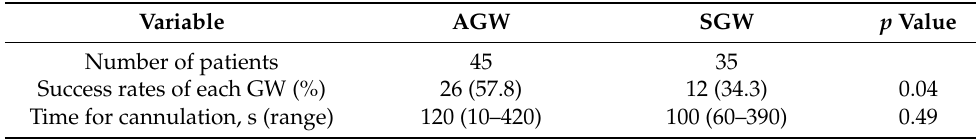
Table 3. Successful selective biliary cannulation rate and time for cannulation for the first 7